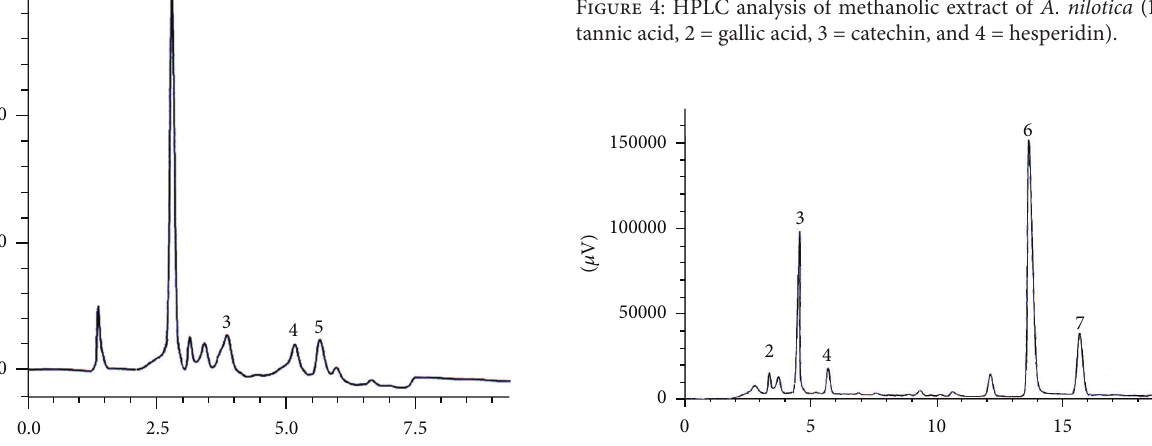
Figure 3: HPLC analysis of methanolic extract of E. jambolana (1 = tannic acid, 3 = catechin, 4 = hesperidin, and 5 = rutin). at RT = 5.6 min ( P. longifolia and E. jambolana ); catechin at RT = 4.2 min ( Z. jujuba , E. jambolana , and A. nilotica ); hesperidin at RT = 5.3 min ( A. nilotica , E. jambolana , and C. zeylanicum ); cinnamic acid at RT = 15.6 min ( C. zeylanicum ).